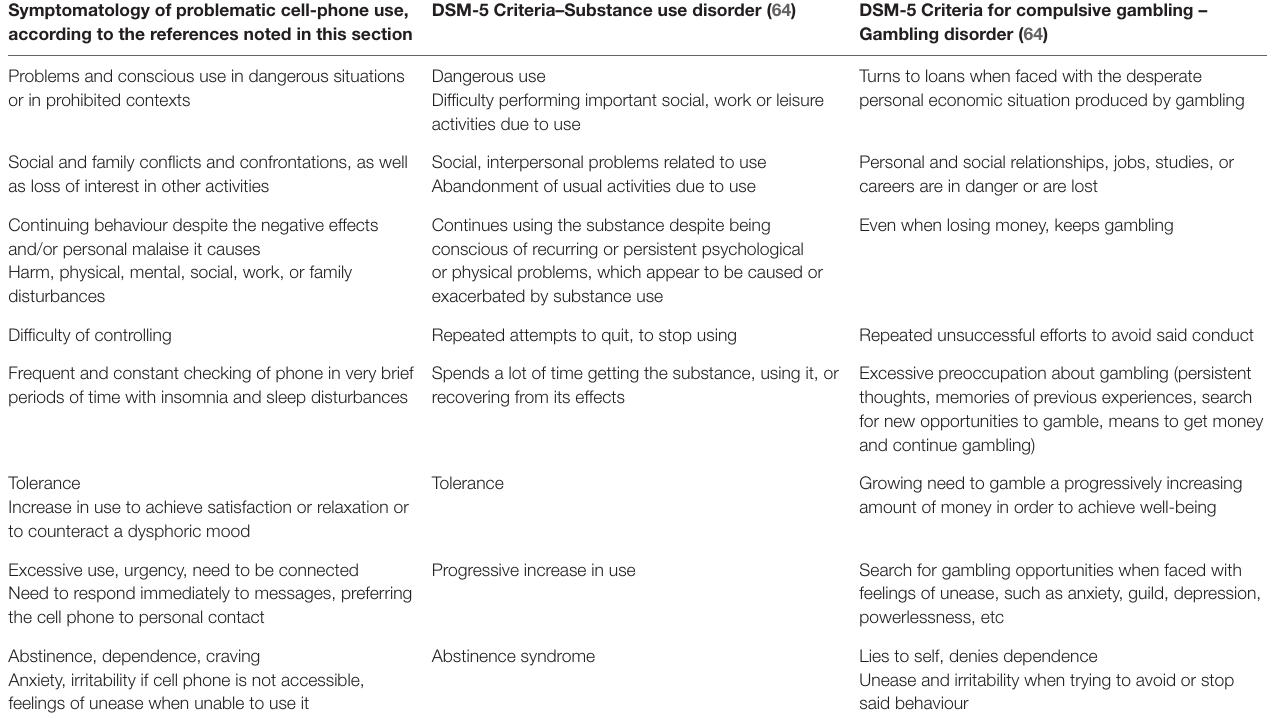
TABLe 1 | Symptomatology of problematic cell-phone use vs. DSM-5 criteria for compulsive gambling and substance use. Symptomatology of problematic cell-phone use, DSM-5 Criteria–Substance use disorder according to the references noted in this section